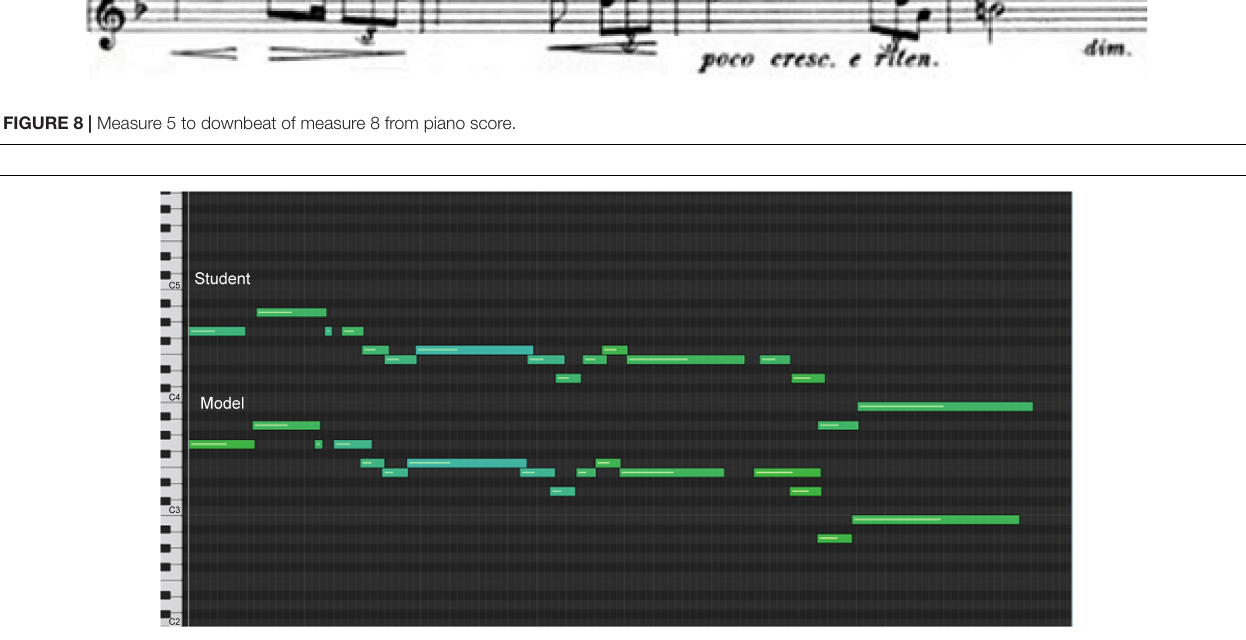
FIGURE 9 | Sonification graph of imitation with